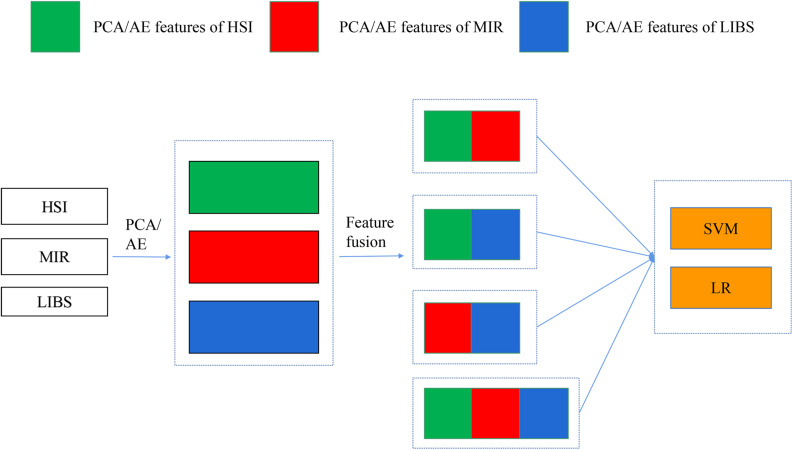
Concatenation of PCA/AE features of different spectra.